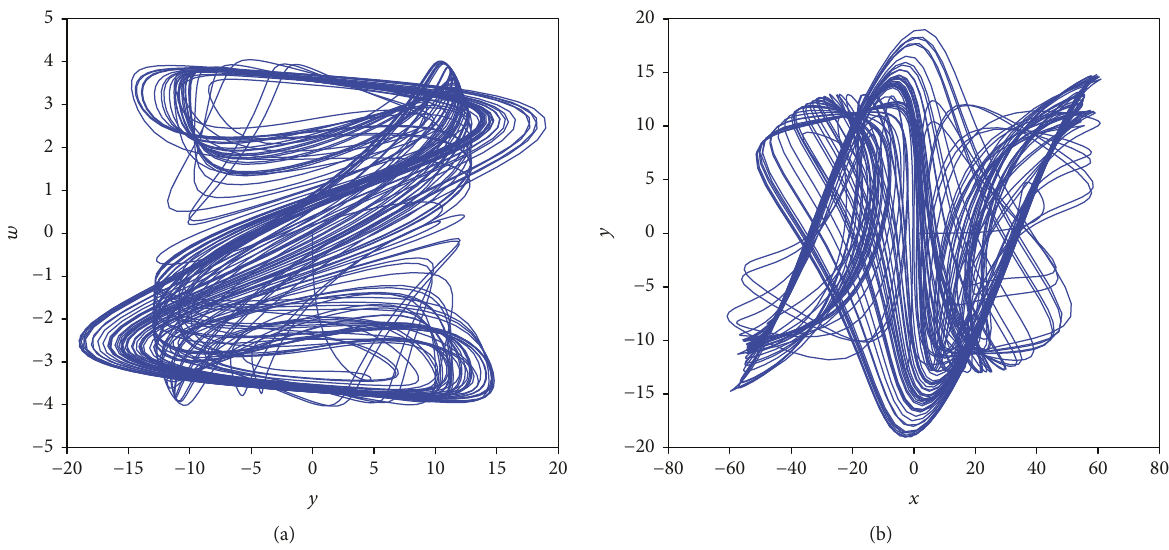
Figure 4: Projections of the double-scroll hyperchaotic attractors onto the y , w and x , y plane. (a) y , w plane. (b) x , y